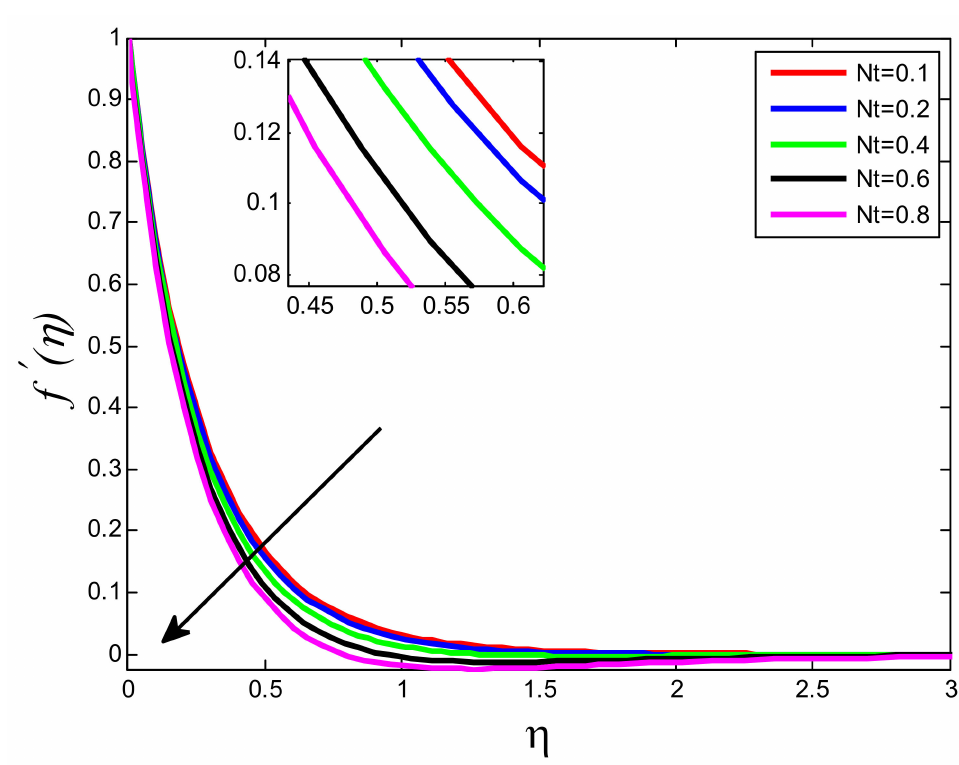
Figure 15. Influence of Nt on f (cid:48) ( η )